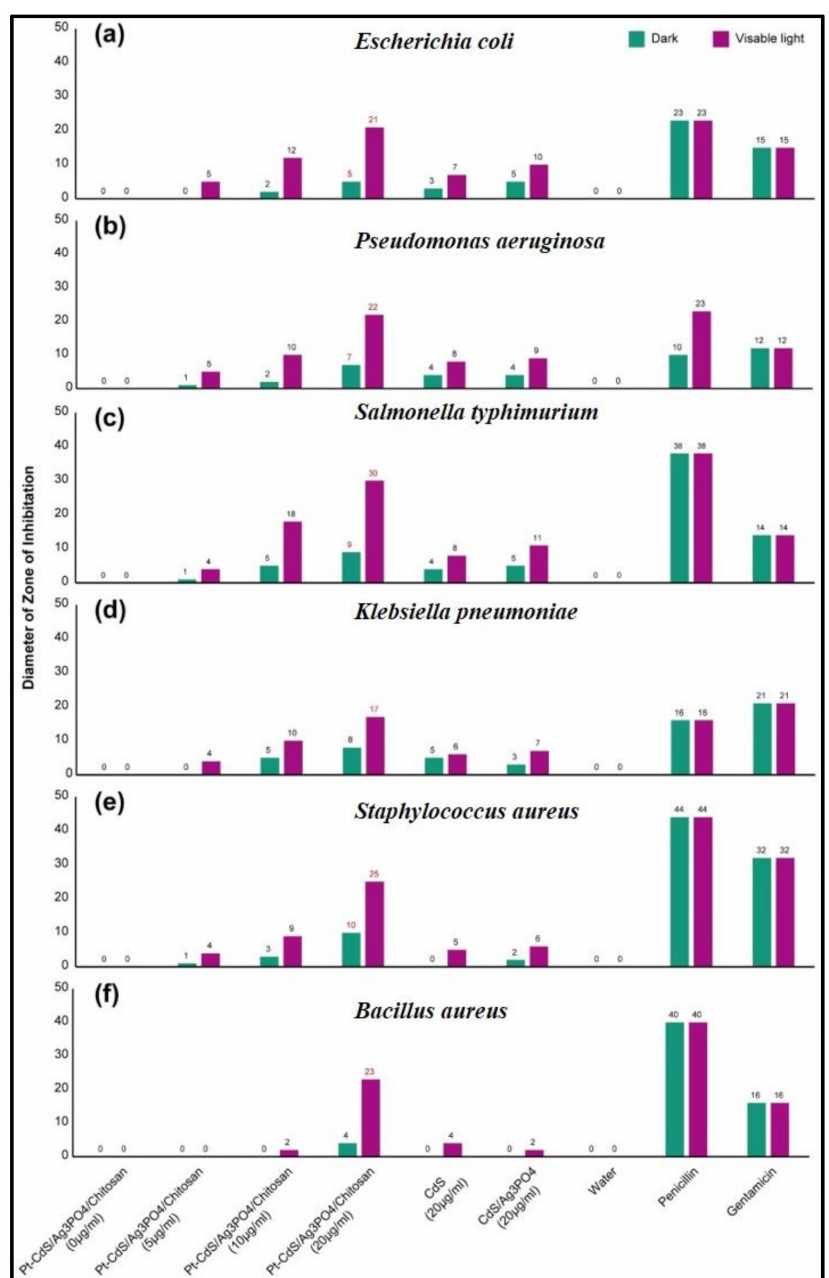
Figure 10. Antibacterial activity study of the prepared samples at di ff erent concentrations on the model ( a ) Escherichia coli , ( b ) Pseudomonas aeruginosa , ( c ) Salmonella typhimurium , ( d ) Klebsiella pneumoniae , ( e ) Staphylococcus aureus , and ( f ) Bacillus cereus bacterium under dark and visible light were tested by the well di ff usion method based on diameter of zone of inhabitation (mm). Water is negative